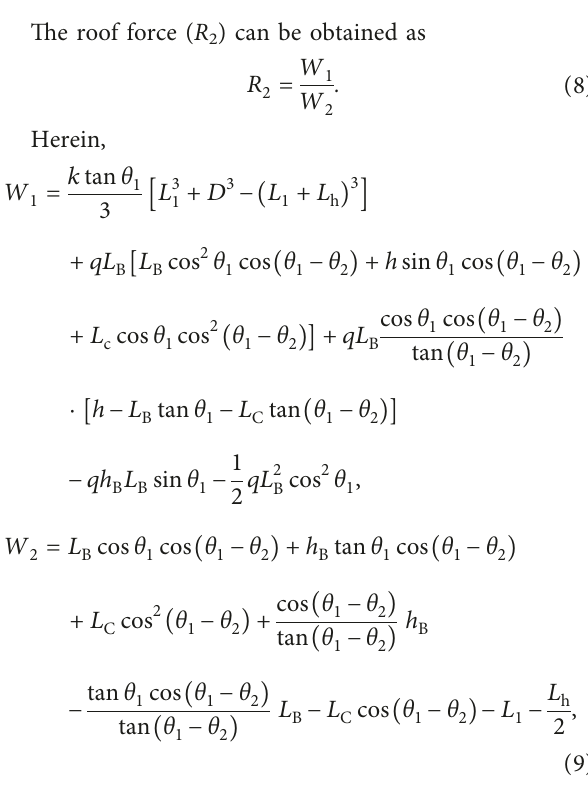
Figure 13: Mechanical model of the triangular arch structure.